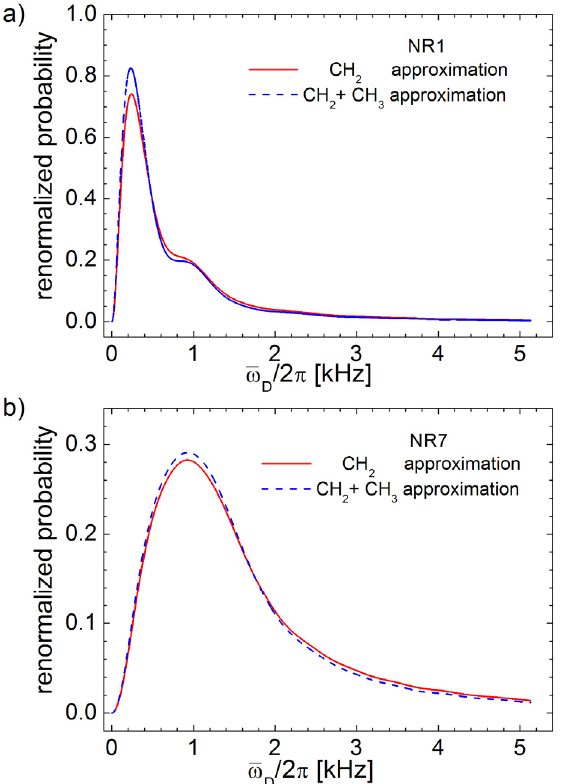
Figure 5. Comparison between DQ Fourier spectra obtained with spin- 1 CH 2 and CH 3 isolated group’s approximation corresponding to ( a ) NR1 and ( b ) NR7-aged samples. In order to be compared, the Fourier spectra were renormalized to have the same integral